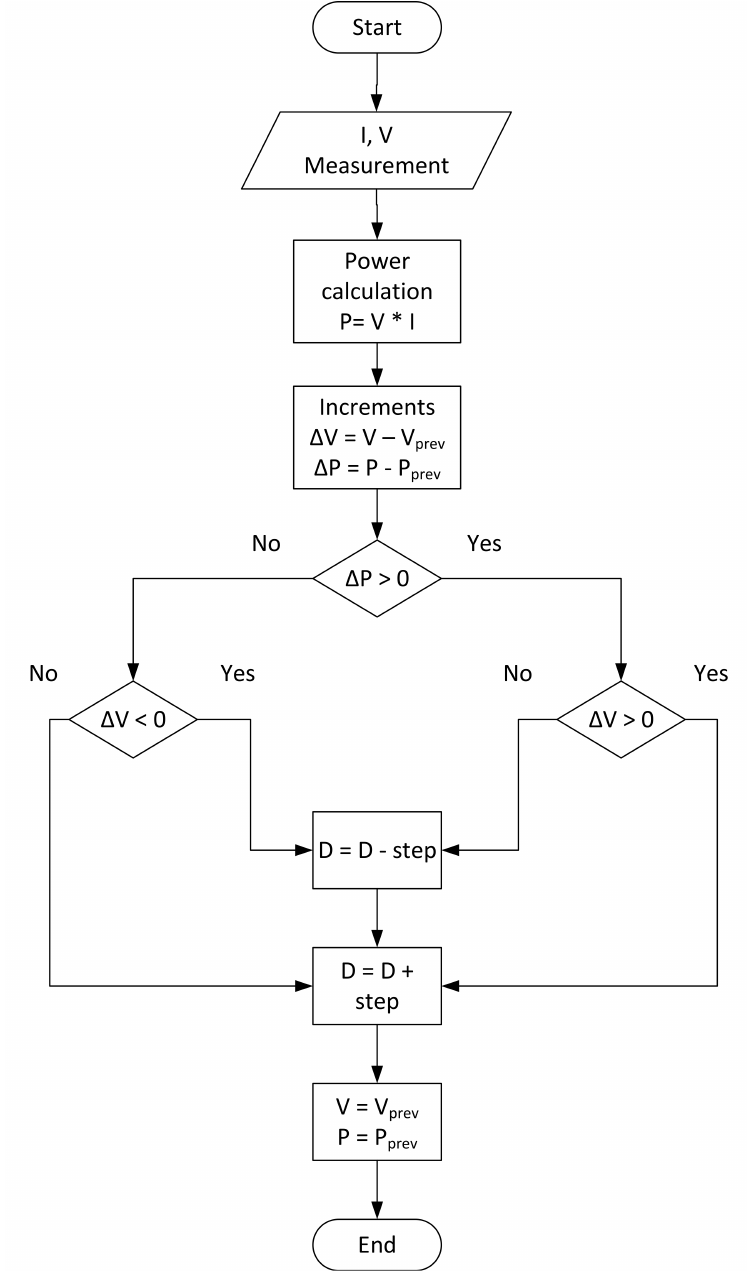
Figure 7. MPPT controller flowchart